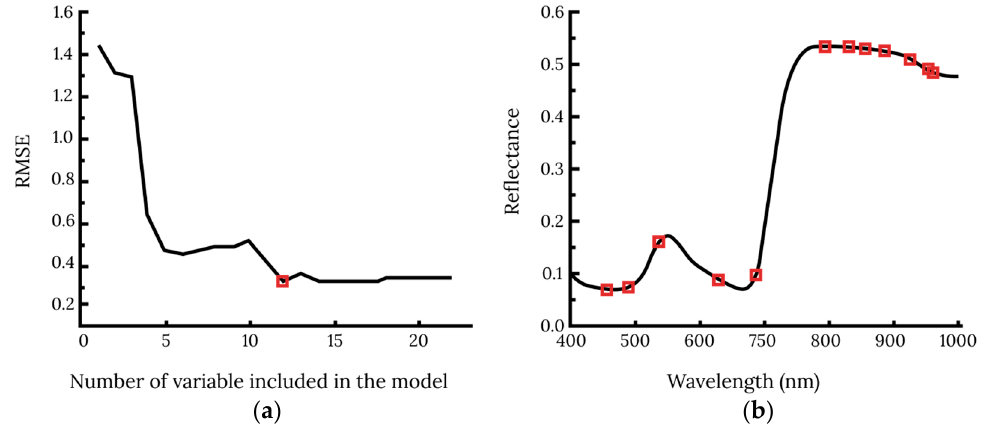
Figure 9. Effective wavelength selection processes for early wheat powdery mildew detection using SPA. ( a ) The number of effective wavelengths determined by the RMSE screen plot. ( b ) The distribution of effective wavelengths indicated by square points [12].